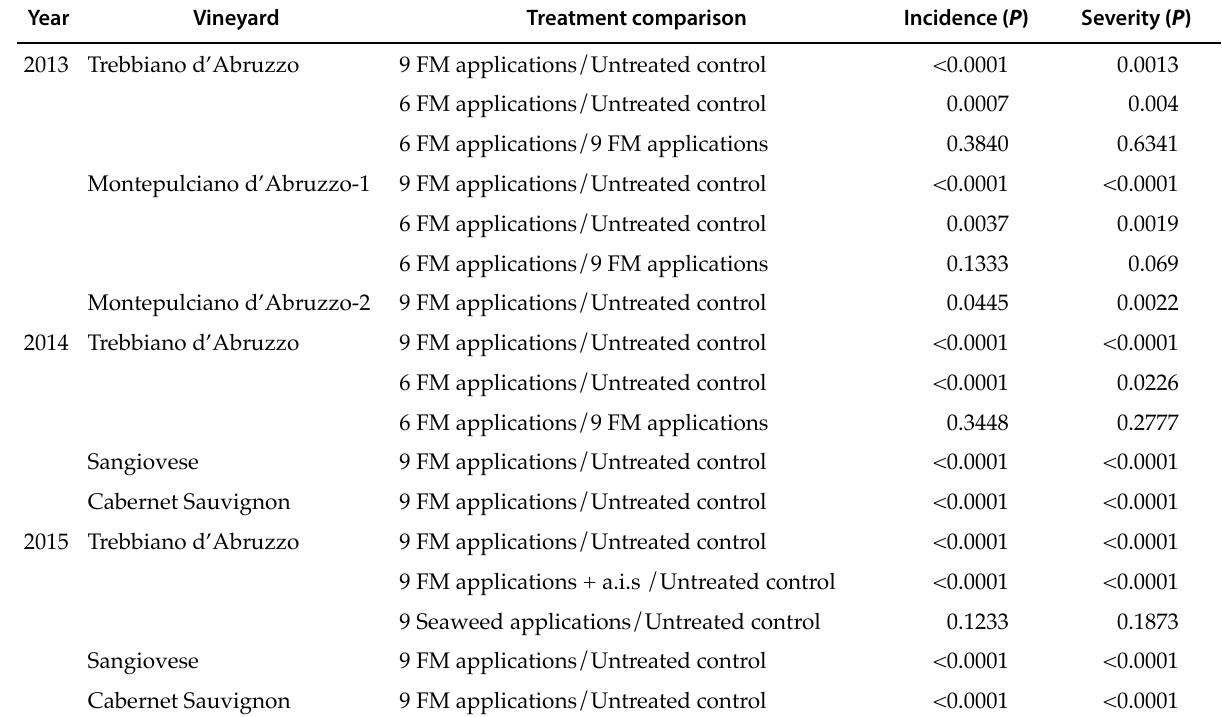
Table 4. Results of Chi-square ( P < 0.05) statistical analyses of data from trials carried out in 2013, 2014 and